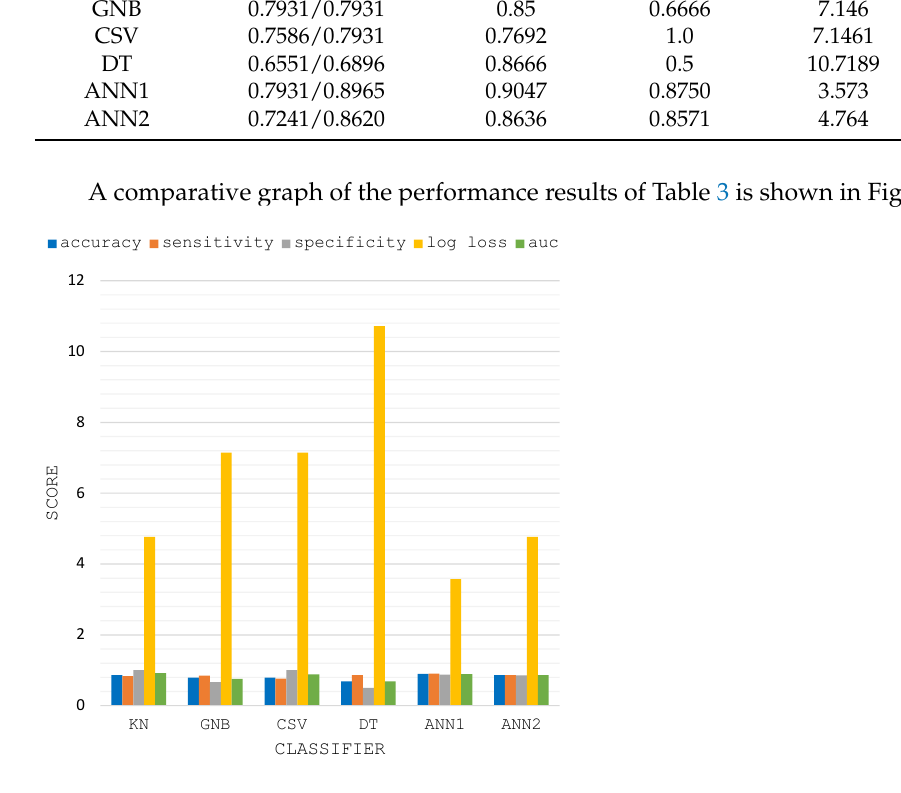
Figure 4. Performance scores by classifier; KN: K-Neighbors; GNB: Gaussian Naive Bayes; CSV: C-Support Vector; DT: Decision Tree; ANN1: Artificial neural network with a single hidden layer; ANN2: Artificial neural network with two hidden layers; ANN1 achieved the highest proportion of correct predictions (0.8965 accuracy), the lesser cross-entropy loss (3.573 log loss) and the highest balanced accuracy (0.8898